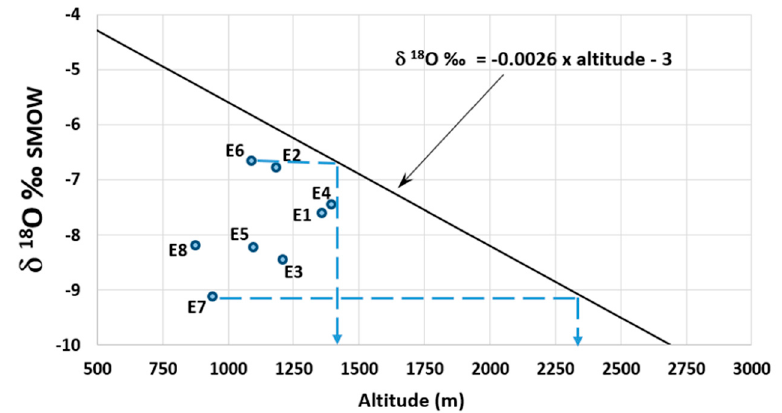
Figure 18. Estimation of the recharge altitudes according to the altitudinal gradient of Oxygene-18 content. Equation of the altitudinal gradient derived from [55].